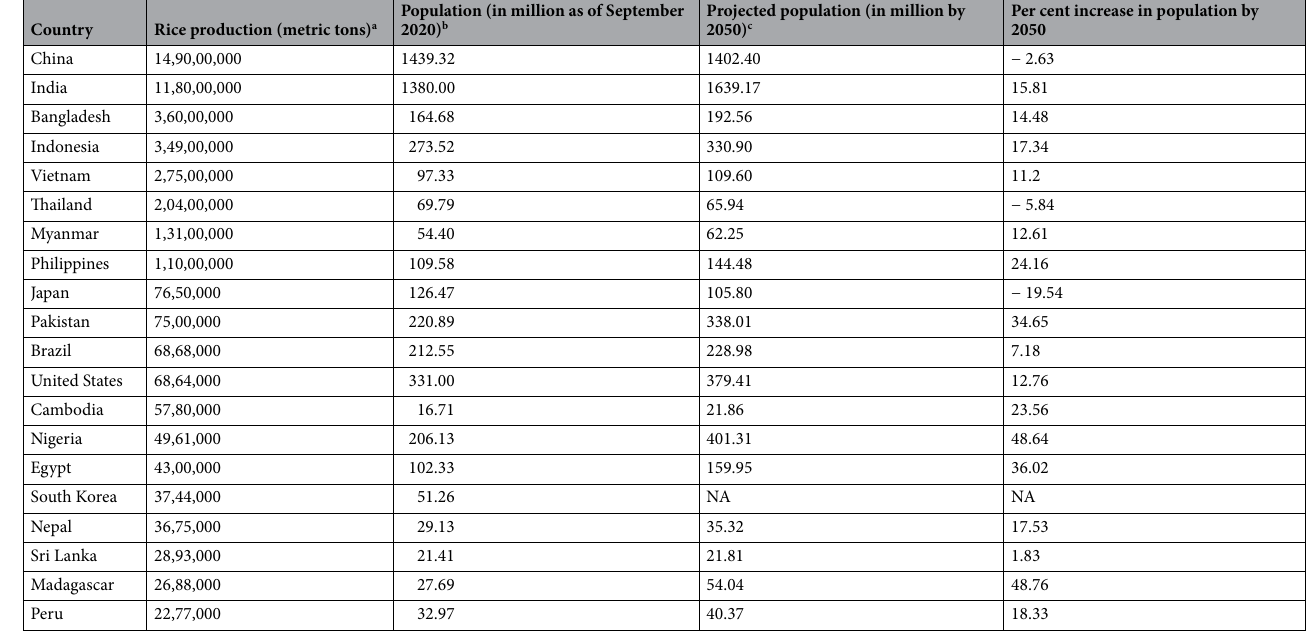
Table 1. Top 20 rice-producing countries, their present (2020), predicted (2050), and per cent increase in population by 2050. NA not available. a www. world agric ultur alpro ducti on. com/ crops/ rice. aspx b www.